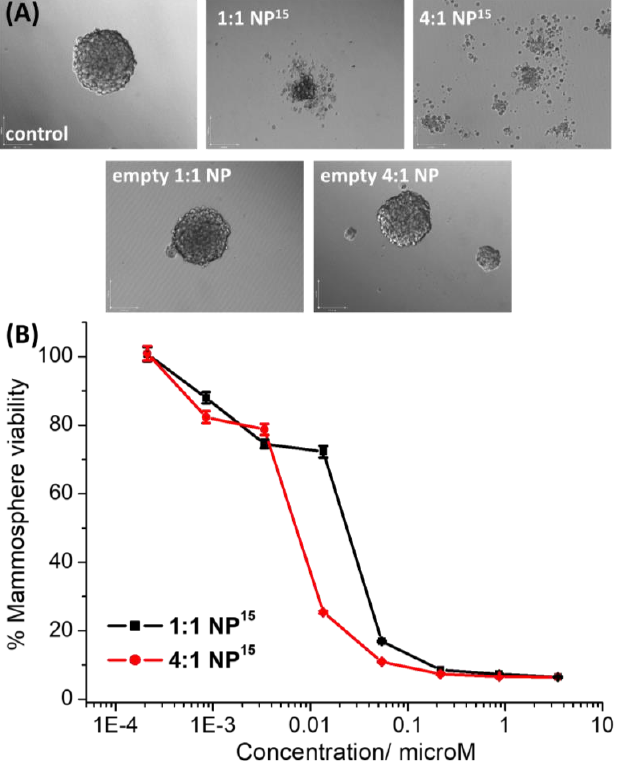
Figure 4. ( A ) Representative bright-field images (×10) of HMLER-shEcad mammospheres in the